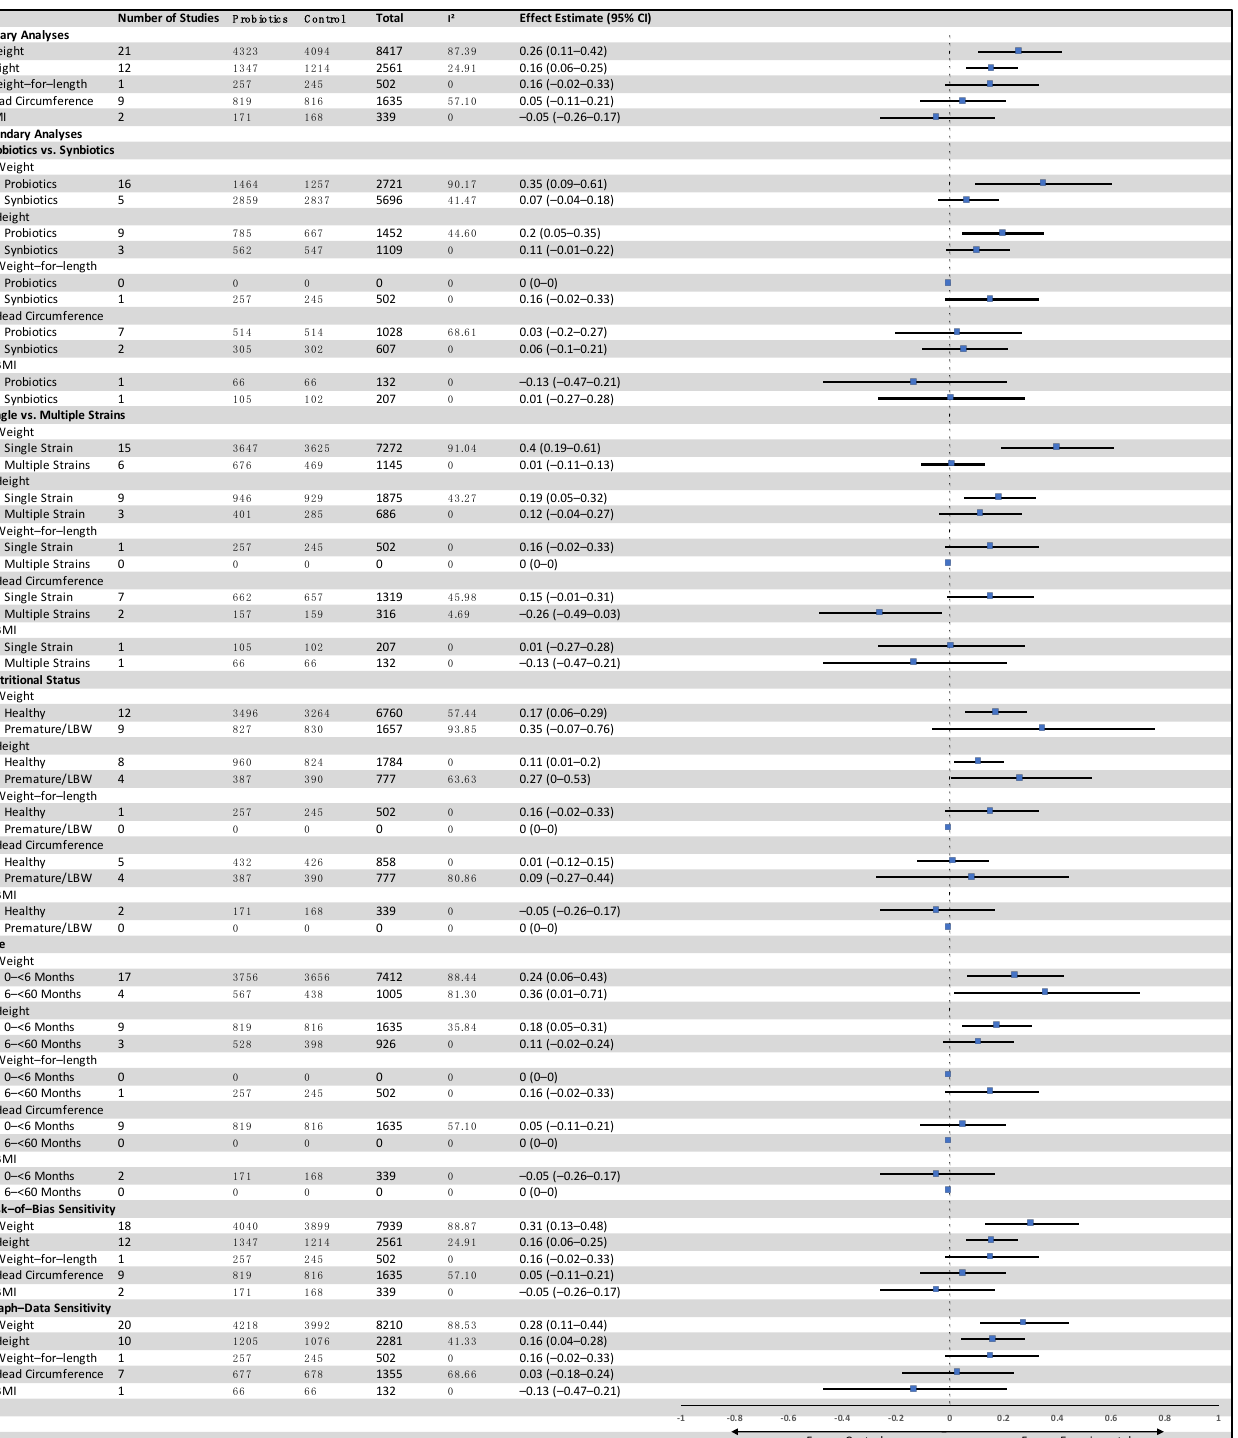
Figure 4. Primary and subgroup analyses for the effects of probiotics and growth outcomes in children from low- and middle-income countries.